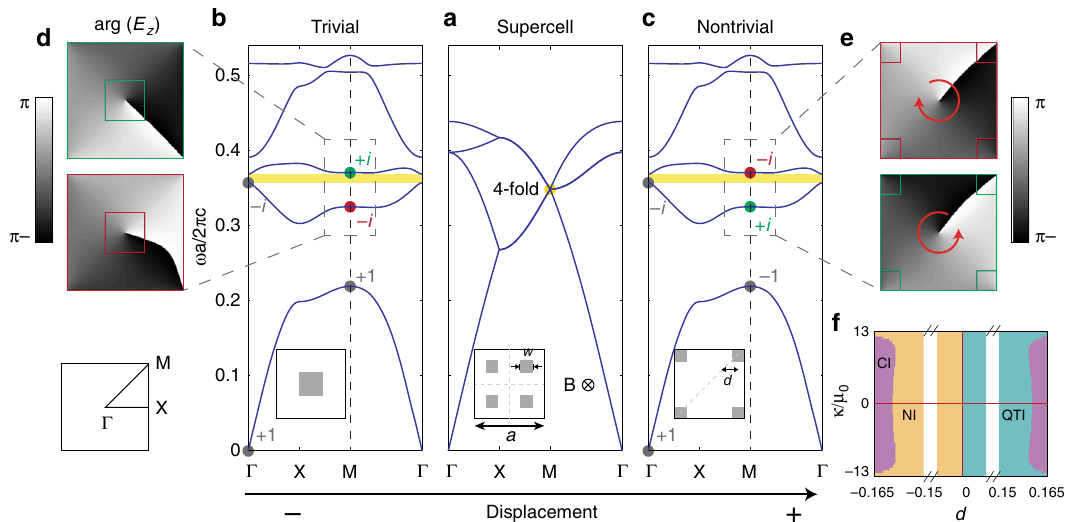
Fig. 1 Quadrupole topological phase transitions through super-cell PhCs. a Band degeneracies are created at the center ( Γ ) and corner (M) of the folded Brilluion zone for a 2 × 2 super-cell PhC (inset). An external magnetic fi eld (B) induces gyromagnetic responses in YIG rods (gray squares), which breaks T but preserves C 4 . The gyromagnetic response κ = 12.4 μ 0 is used in the calculations. b , c As the rods simultaneously move inward or outward, the second gap is opened (shaded in yellow), but with different quadrupole phases: inward (outward) displacements with negative (positive) d correspond to trivial (non-trivial) quadrupole phases. d , e E z mode pro fi les for the second and third modes at M feature a band inversion between the modes with C 4 index of + i (green) and − i (red) in the trivial and non-trivial phases. f Complete topological phase diagram of the PhCs, including quadrupole phases (green), trivial phases (orange), and Chern insulating phases (purple). Systems are gapless along the axes (red). NI normal insulator, QTI quadrupole insulator, CI Chern insulator.